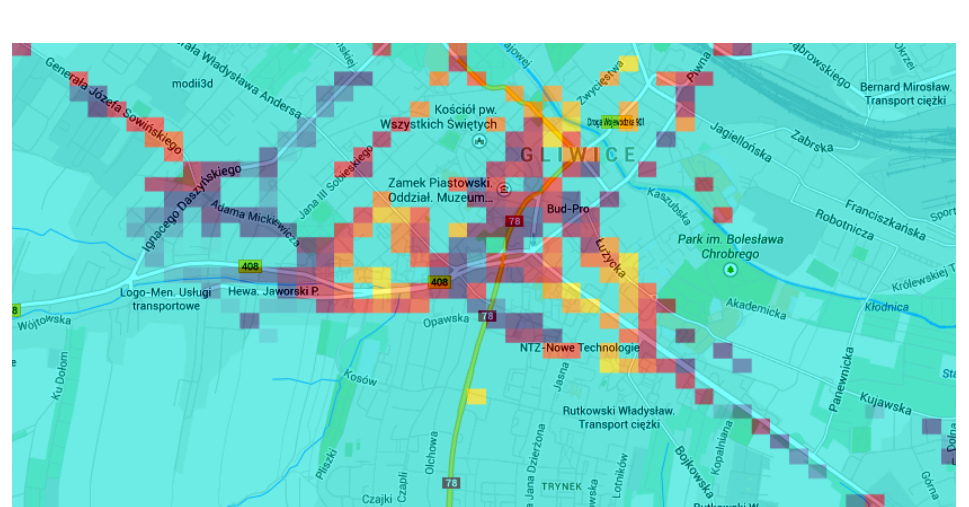
Figure 17. LTE signal heat map (map data c (cid:13) 2014 by